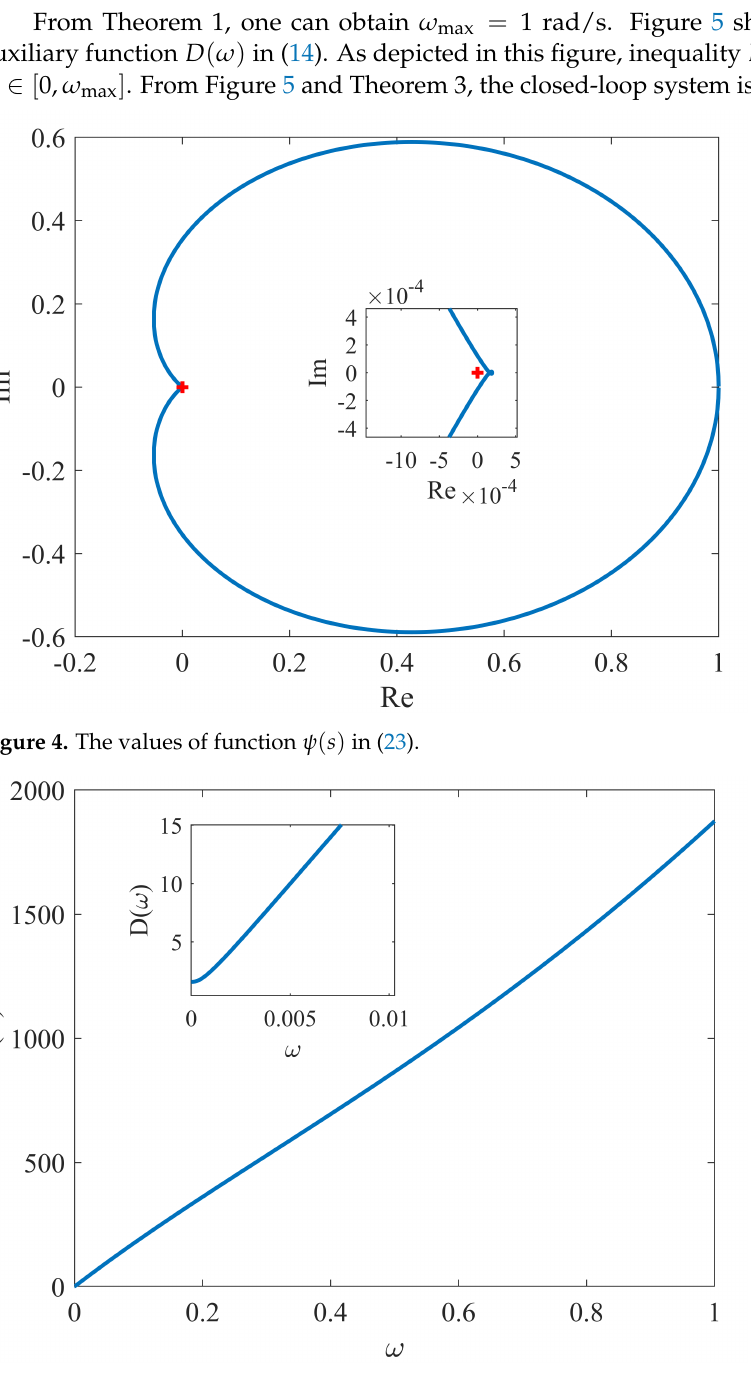
Figure 5. The curve of auxiliary function D ( ω ) in (14) for Example